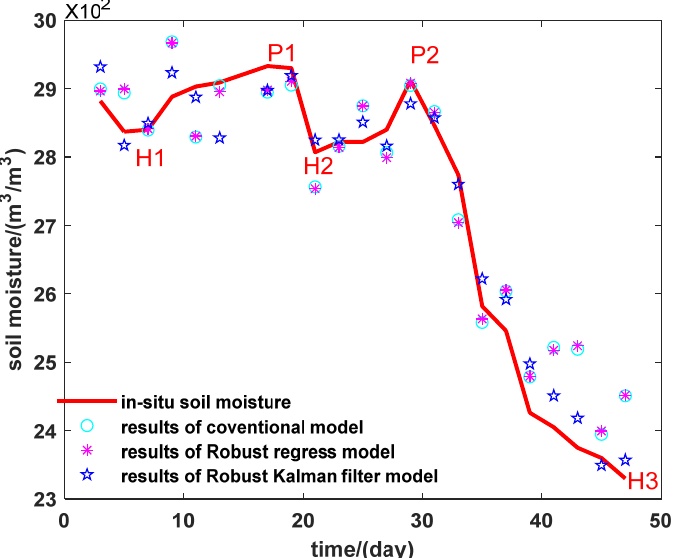
Figure 10. Estimation results of multivariate variable dual-band data fusion methods (PRN1), we highlighted for validation data the main moisture peaks (P1 day 17; P2 day 29) and holes (H1 day 6; H2 day 20; and H3 day 47). We can note that the difference between H1 and P1 is less than 1*10 -2 m 3 /m 3 and between H2 and P2 it is ~1*10 -2 m 3 /m 3 which is low and will allow us to test the precision of the inversions and to show the capacity of this technique to differentiate between very weak soil moisture fluctuations.